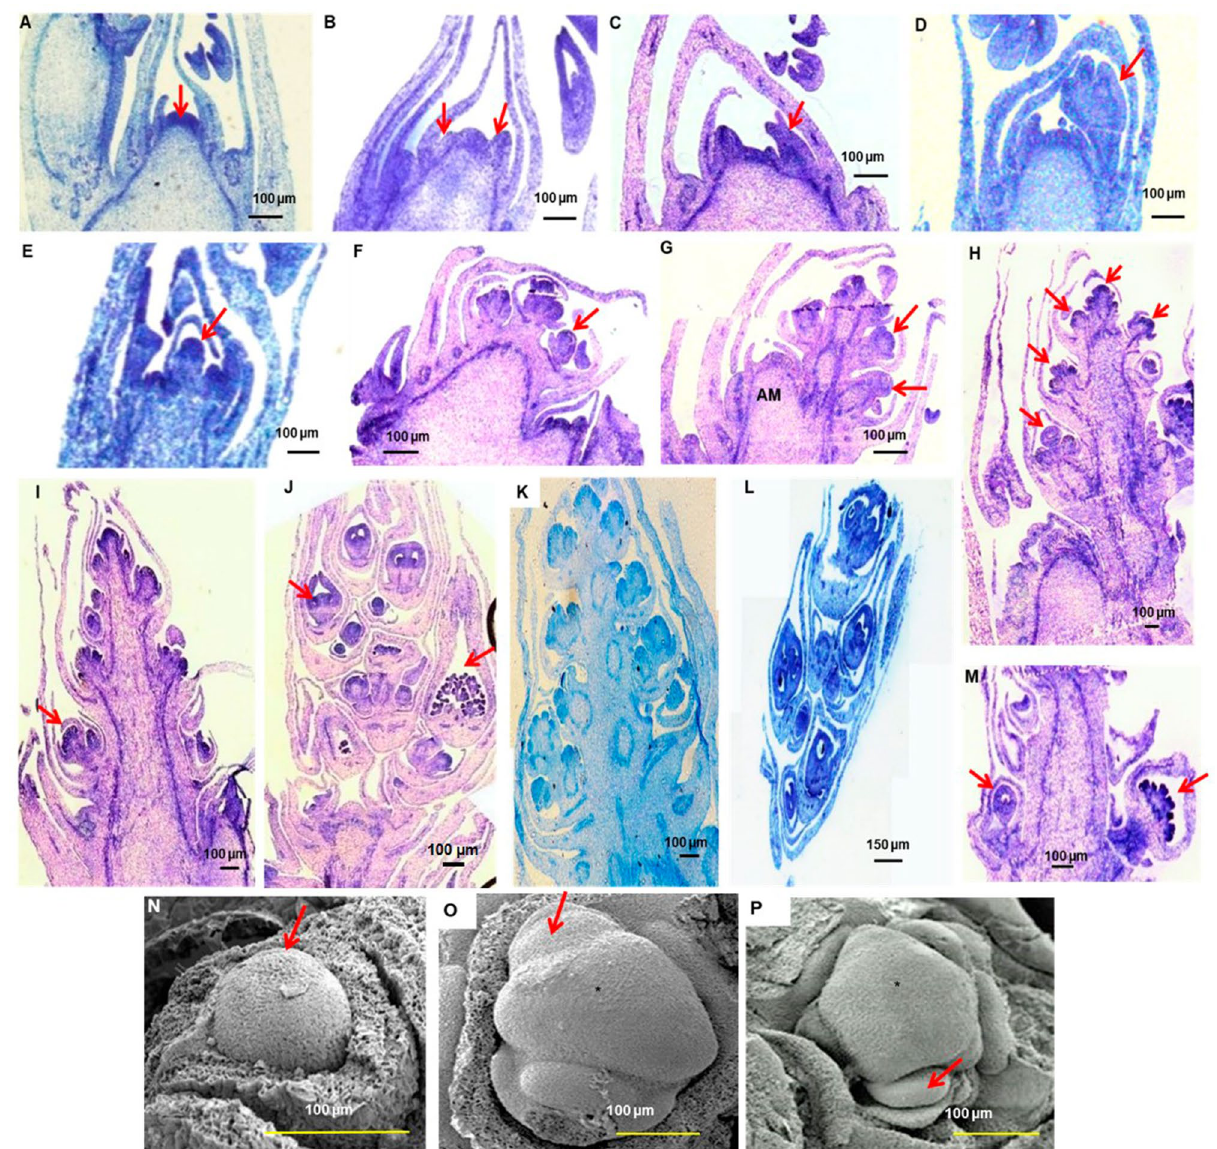
Figure 3. Chronology of development stages of apical meristem during raceme formation. ( A–D ) Vegetative shoot apical meristem (SAM) at different developmental stages. Arrows indicate SAM and bract or leaf primordia ( E ) Inflorescence primordia initiation. ( F,G ) Floral primordia differentiation. AM is apical meristem. Arrows indicate floral meristem ( H–J ) Inflorescence elongation and differentiation of buds. Arrows indicate male and female bud ( K–M ) Lower floral whorls with ( K ) only male (RG 156) ( L ) only female (DPC 9) and ( M ) both male and female flowers (DCS 107). Sections are of ×40 magnification. ( N–P ) Scanning Electron Micrographs of shoot apical meristem (SAM) ( N ) SAM during vegetative growth (arrow) ( O ) Bract and/or leaf primordia (arrow). Asterisk indicates SAM. ( P ) SAM during inflorescence initiation. Arrow indicates floral meristem. Asterisk indicates inflorescence meristem. Scale bars are shown